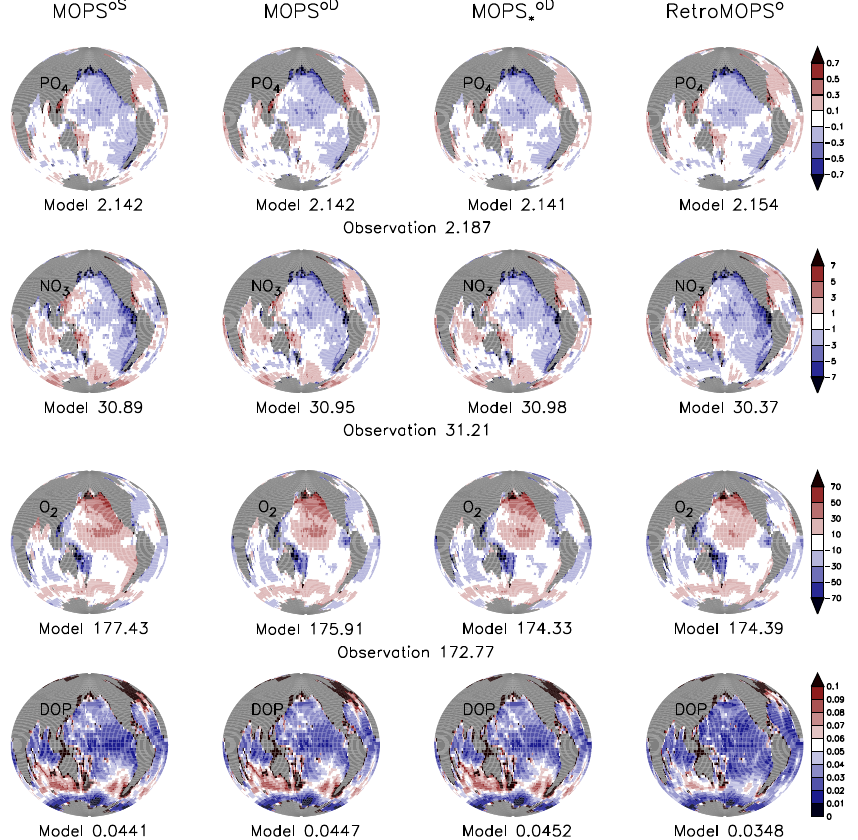
◦ S ◦ D ◦ D ◦ . Top: phosphate. Second row from top: nitrate. , MOPS , MOPS ∗ and RetroMOPS